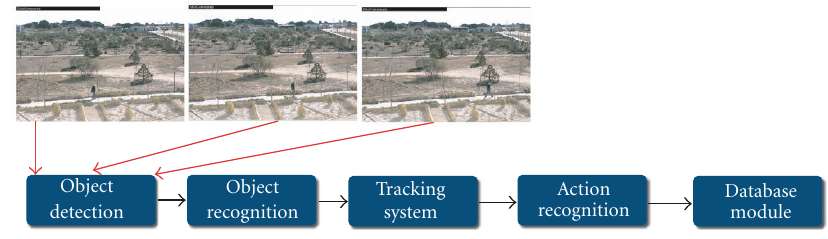
Figure 1: A generic video processing framework for an automated visual surveillance